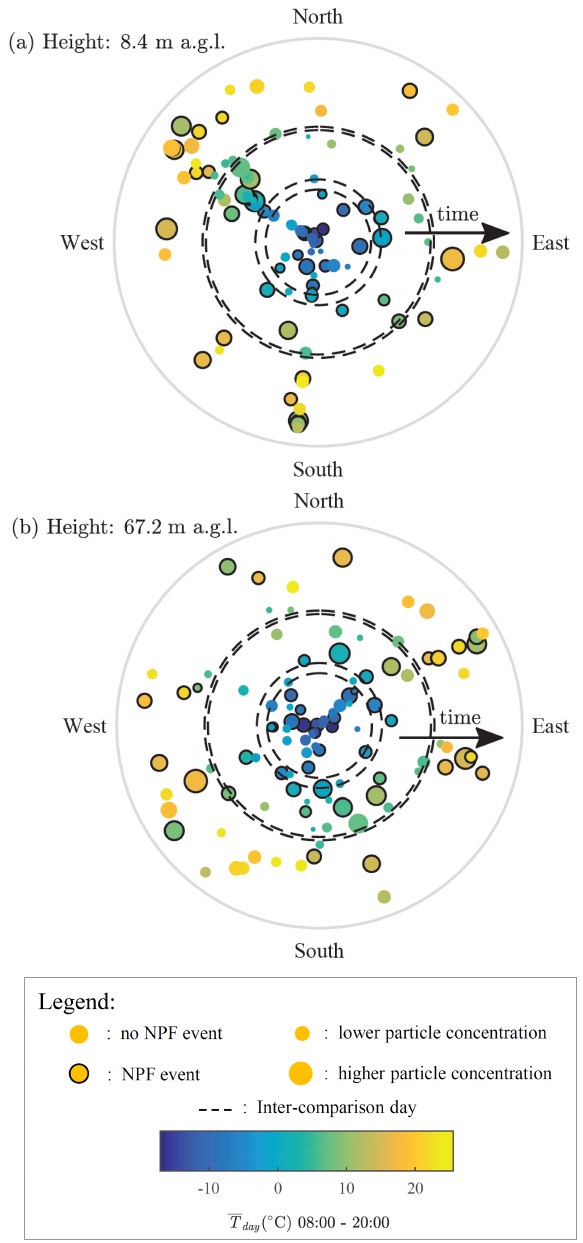
Figure 7. Wind roses representing multiple aerosol features, in- cluding relative average particle concentration (calculated from the SMEAR II DMPS and APS concentrations) and NPF events, as a function of air temperature, wind direction and time at 8.4 (a) and 67.2m (b) above ground level on the